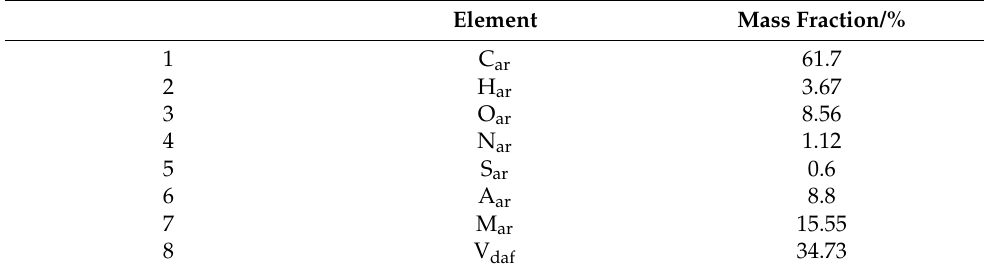
Table 1. Elemental analysis of coal.